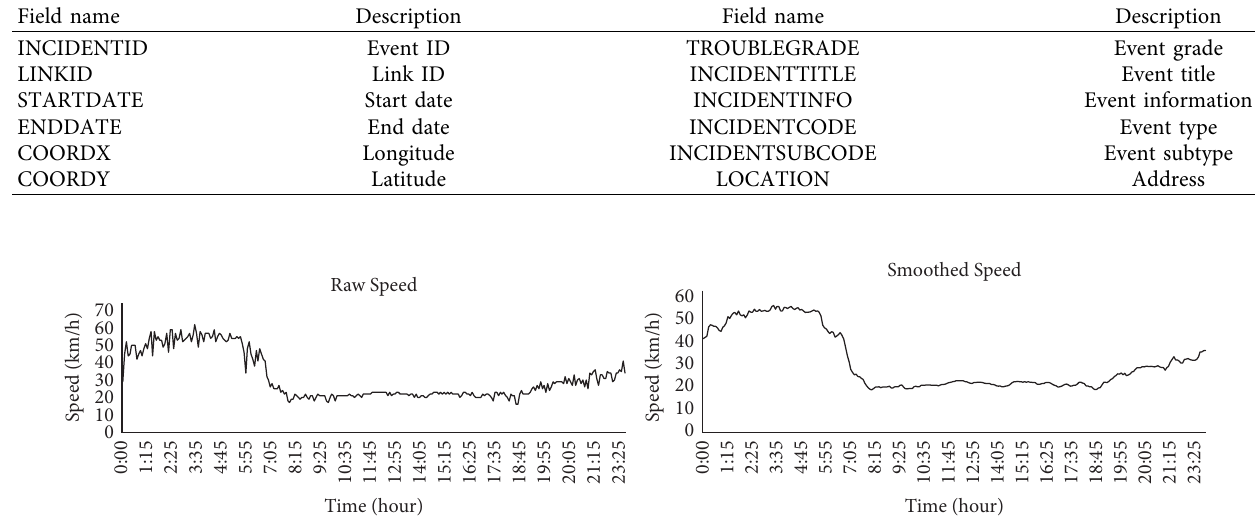
Figure 1: Smoothed historical speed data. (a) Raw data. (b) Smoothed